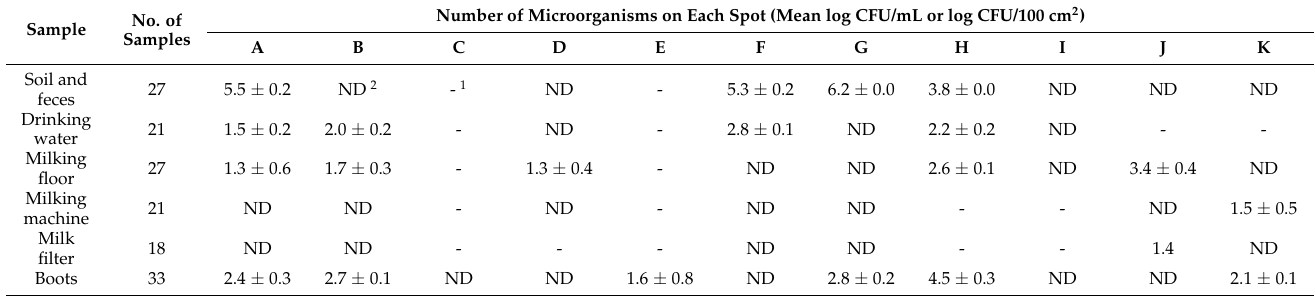
Table 8. Mean ( ± SD) coliform counts in the environment of each dairy farm (A to K).